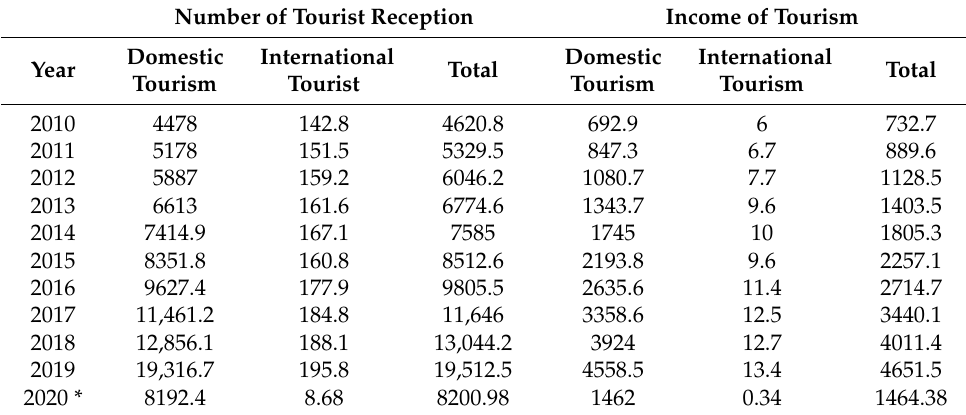
Table 1. Tourist reception and Income of tourism in Inner Mongolia.